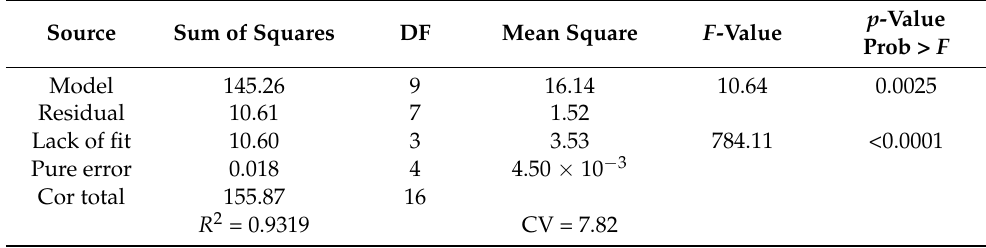
Table 3. ANOVA for the fitted quadratic polynomial model of extraction of crude